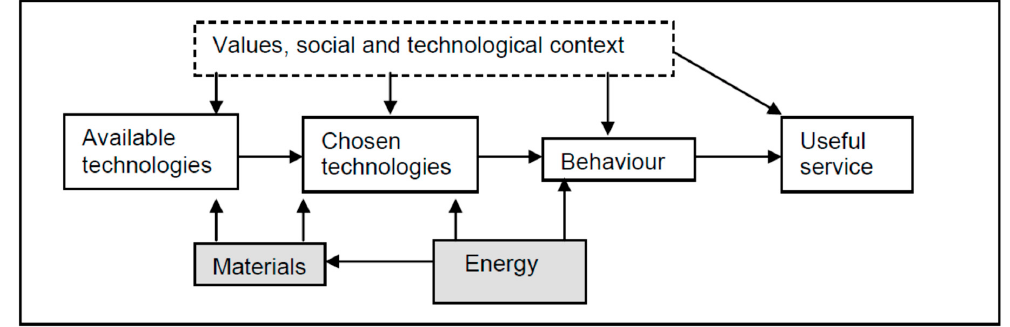
Figure 1. High level model of factors contributing to ‘useful services’ for which energy is one input [1].